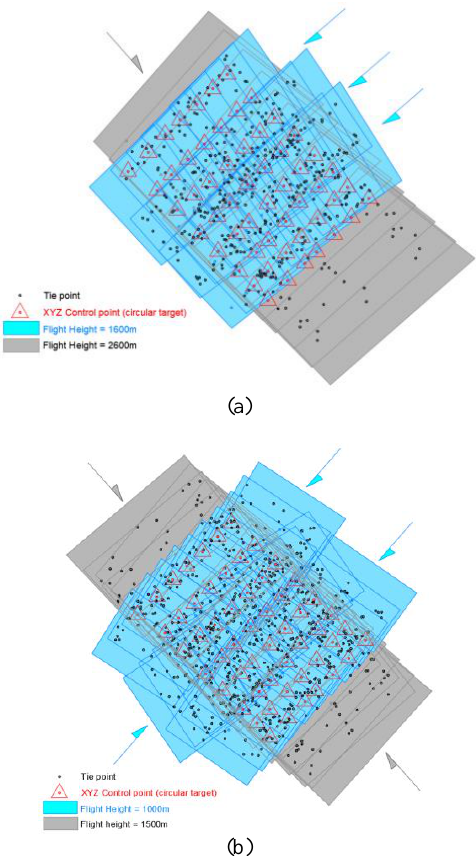
Figure 3. (a) First block layout configuration. (b) Second block layout configuration. (Ercolin Filho et al., 2017) three-dimensional coordinates (X, Y, Z) were determined using GNSS (Global Navigation Satellite System) surveying